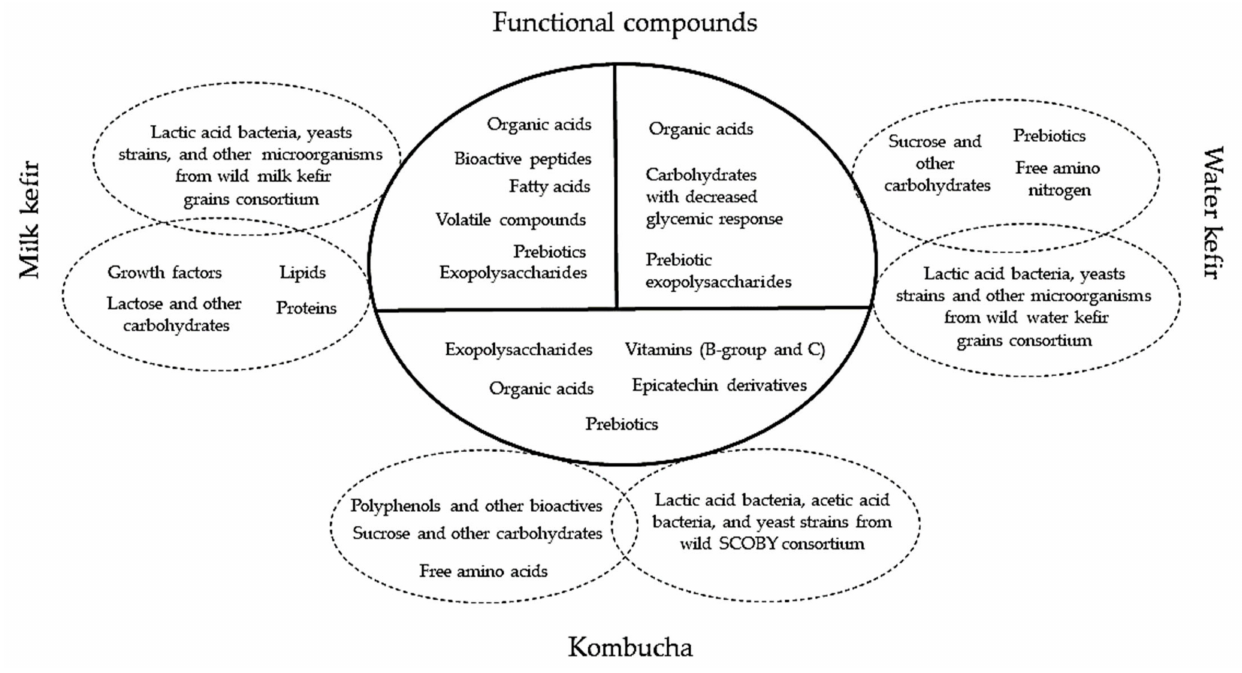
Figure 8. Functional metabolites within the milk and water kefir, and respectively kombucha